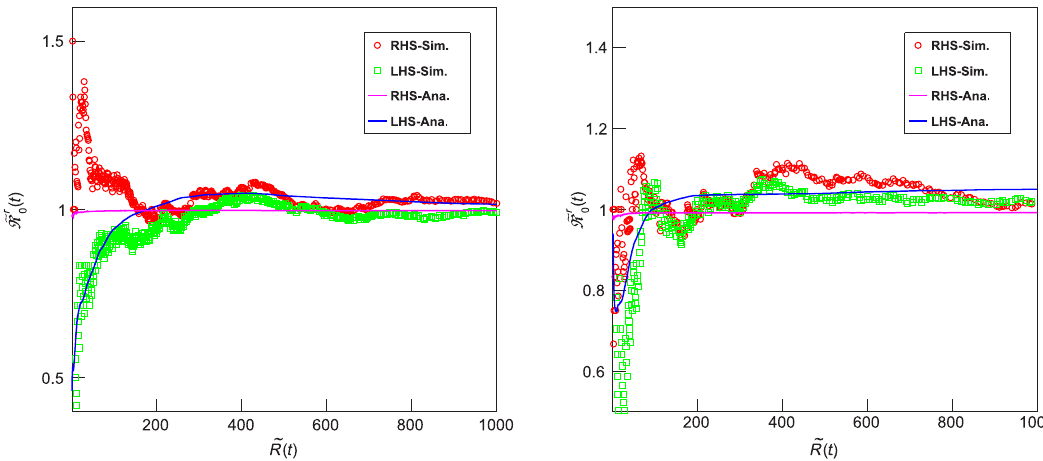
FIG. 7. The estimated basic reproduction number of removed individuals for the binomial (left panel: z 1 ¼ 5 , (cid:1) i ¼ 0 : 127 71 , and 0 : 25 ) and exponential (right panel: (cid:5) ¼ 4 ) networks in terms of the number of removed individuals. The right-hand and left-hand (cid:1) r ¼ sides represent the right- and left-hand sides of Eq. (27), respectively. The solid curve represents the ‘‘analytical’’ calculation of Eq. (27) and the symbols show the ‘‘exact’’ values of the right-hand and left-hand sides for this specific realization of the epidemic